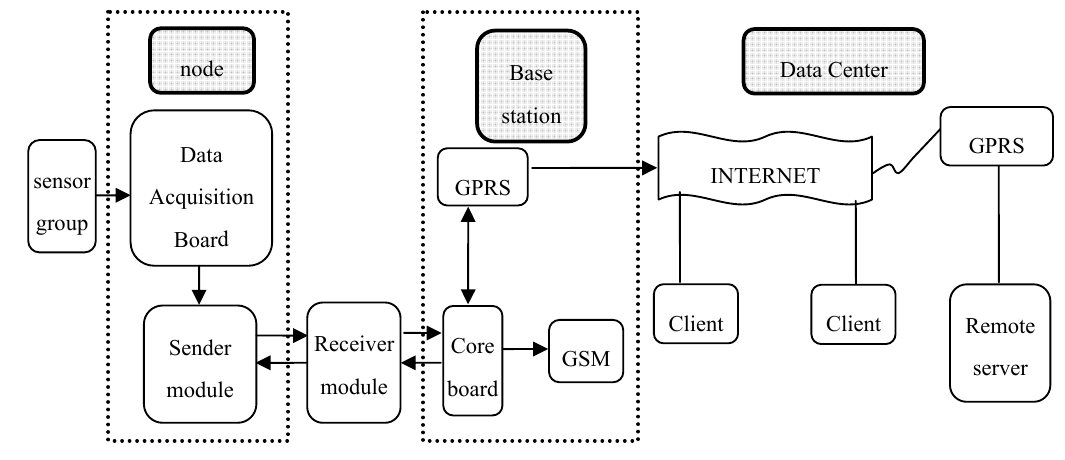
Figure 1. Architecture of greenhouse monitoring system based on wireless sensor network.